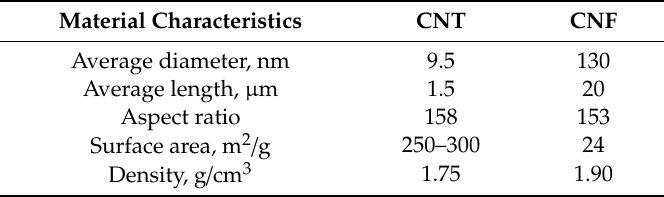
Table 1. Characteristics of the carbon nanotubes (CNT) [16] and carbon nanofibres (CNF) [17] according to manufacturers’